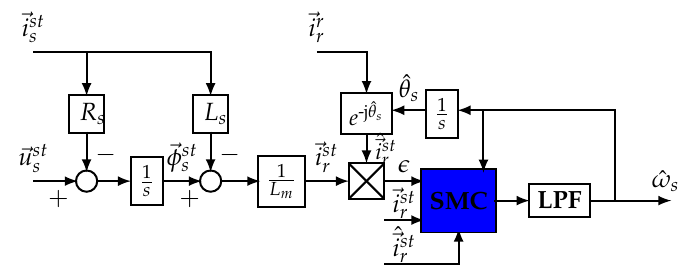
Figure 2. The proposed SMC-MRAS